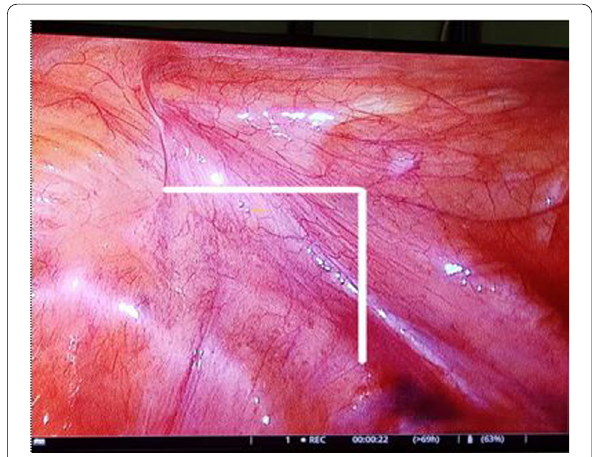
Fig. 1 The inner ring of inguinal canal